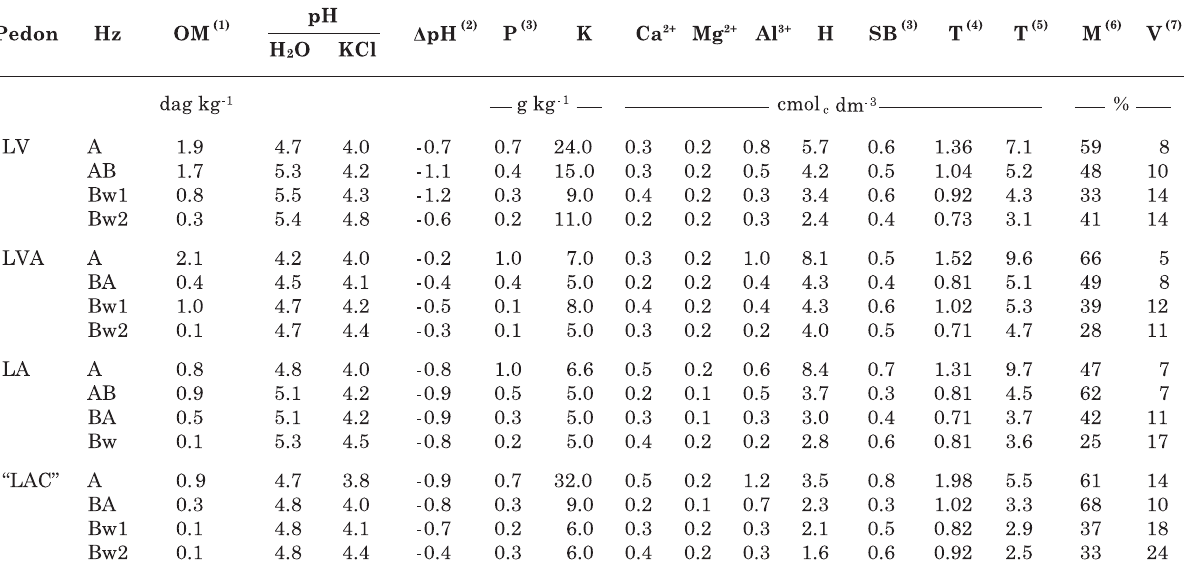
O /TiO ratio of the 2 3 2